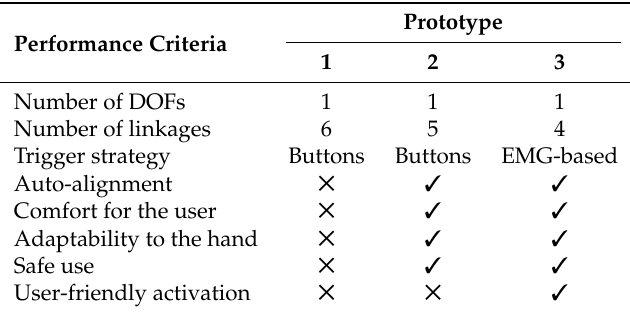
Table 2. Results achieved in the design of the three developed prototypes. Symbol (cid:51) indicates the achievement of an acceptable level for the feature reported on the first column of the table, while symbol (cid:53) points out an open up point that had to be revised in the next